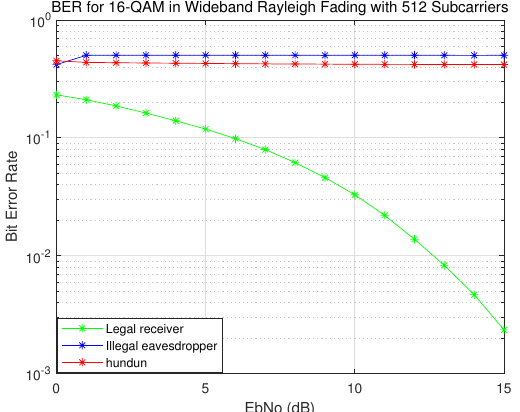
Figure 11. BER for legal receiver and illegal